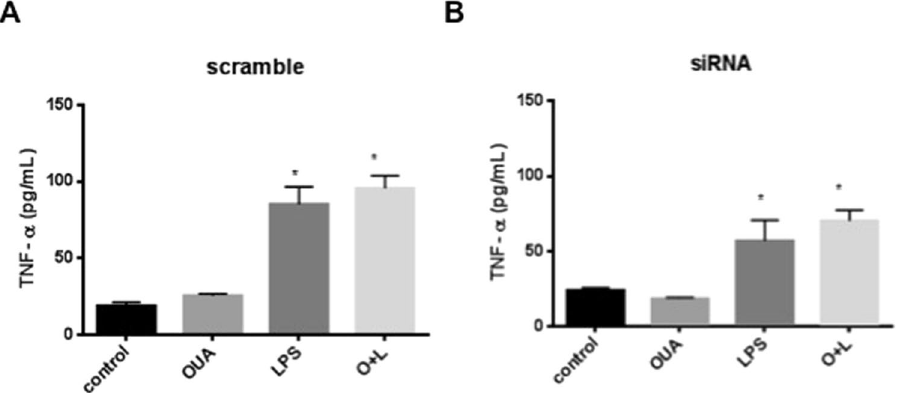
Figure 6. The lack of α 2-Na + ,K + -ATPase decreases TNF- α levels. Cell culture supernatants of scrambled sequence and siRNA cells after treatment with LPS (1 µ g/mL) and OUA (10 µ M) were collected and used to measure TNF- α levels by ELISA (n = 6). ( A ) The levels of TNF- α in the scrambled group, * p < 0.05 vs control and OUA. ( B ) The levels of TNF- α in the siRNA group, * p < 0.05 vs control and OUA. ( C ) Comparison of the levels of TNF- α in the siRNA and scramble groups, * p < 0.05 vs scramble + LPS and scramble + O + L.